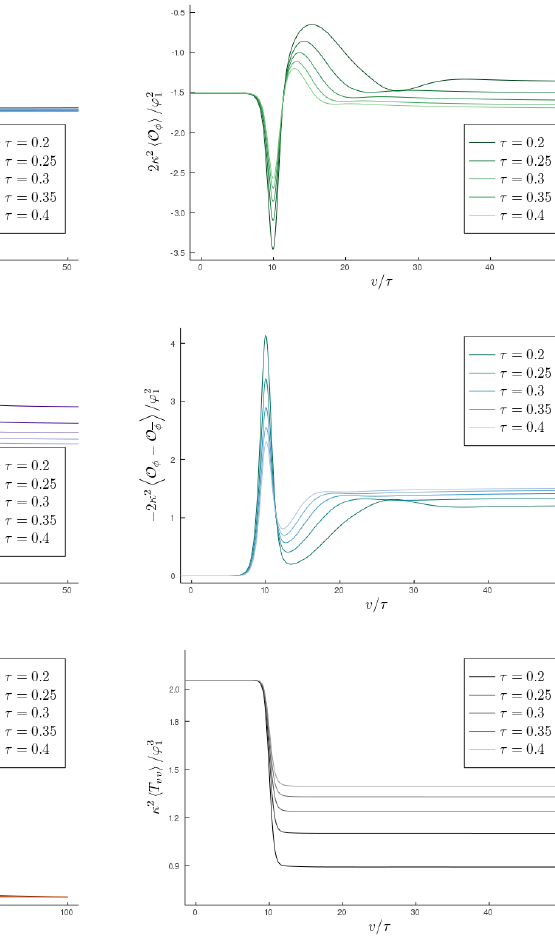
= 0 and a final value ξ i